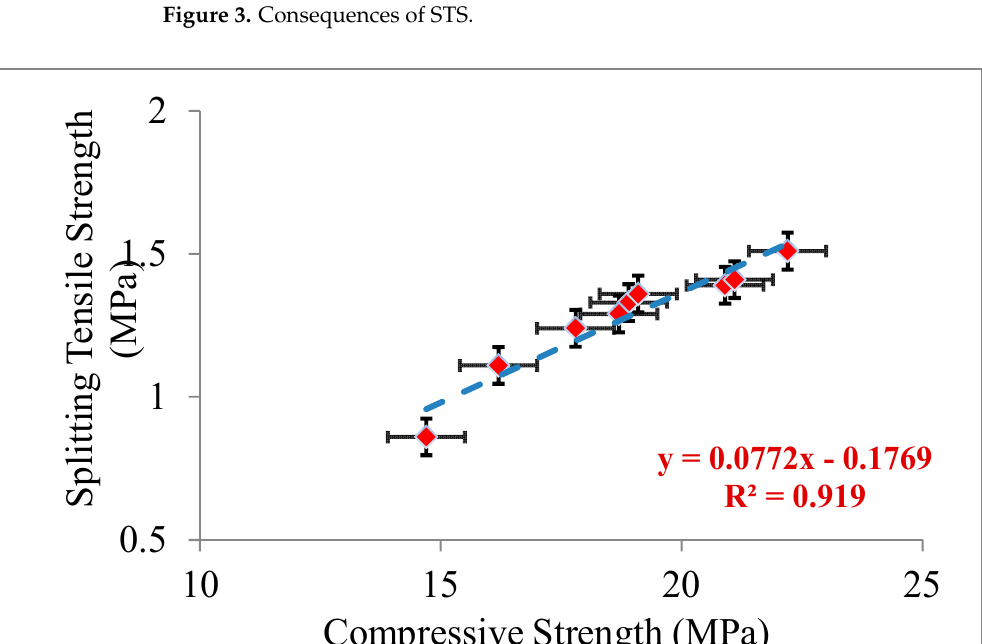
Figure 3. Consequences of STS.